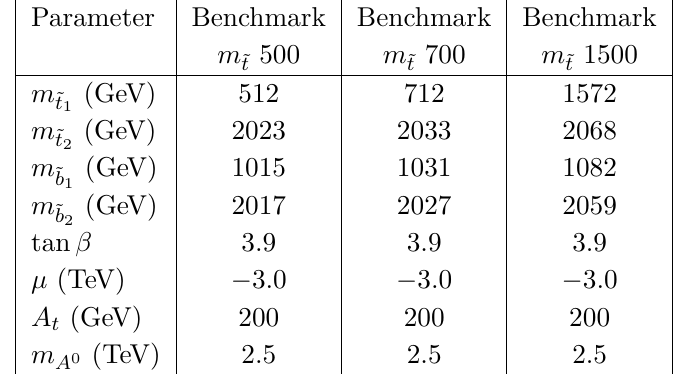
Main parameters of the MSSM-like benchmark scenarios used in the SMEFT validity